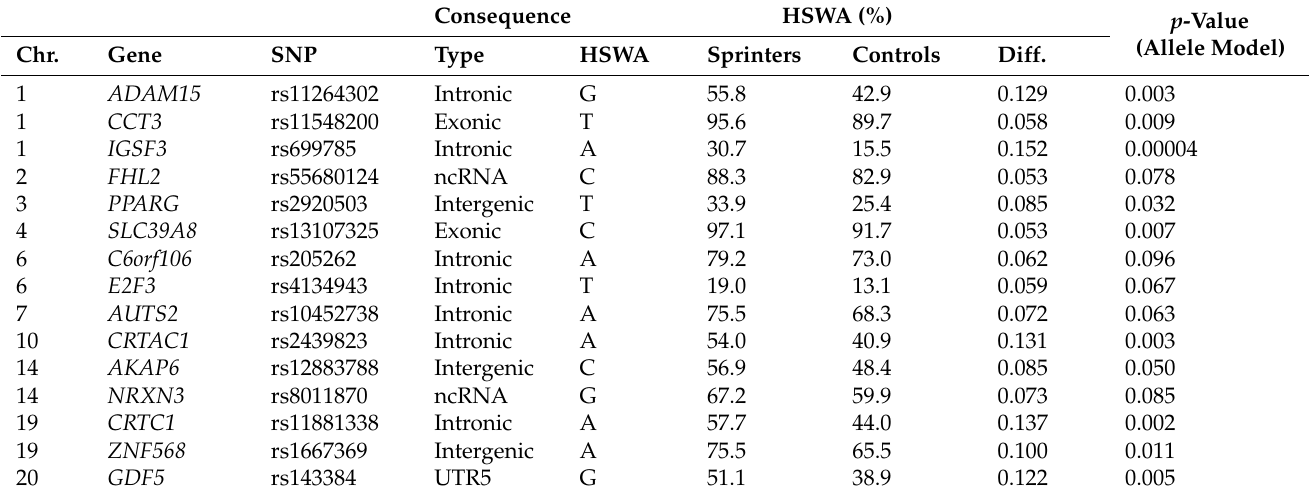
Table 1. Fifteen SNPs related to self-reported walking pace associated with sprinter